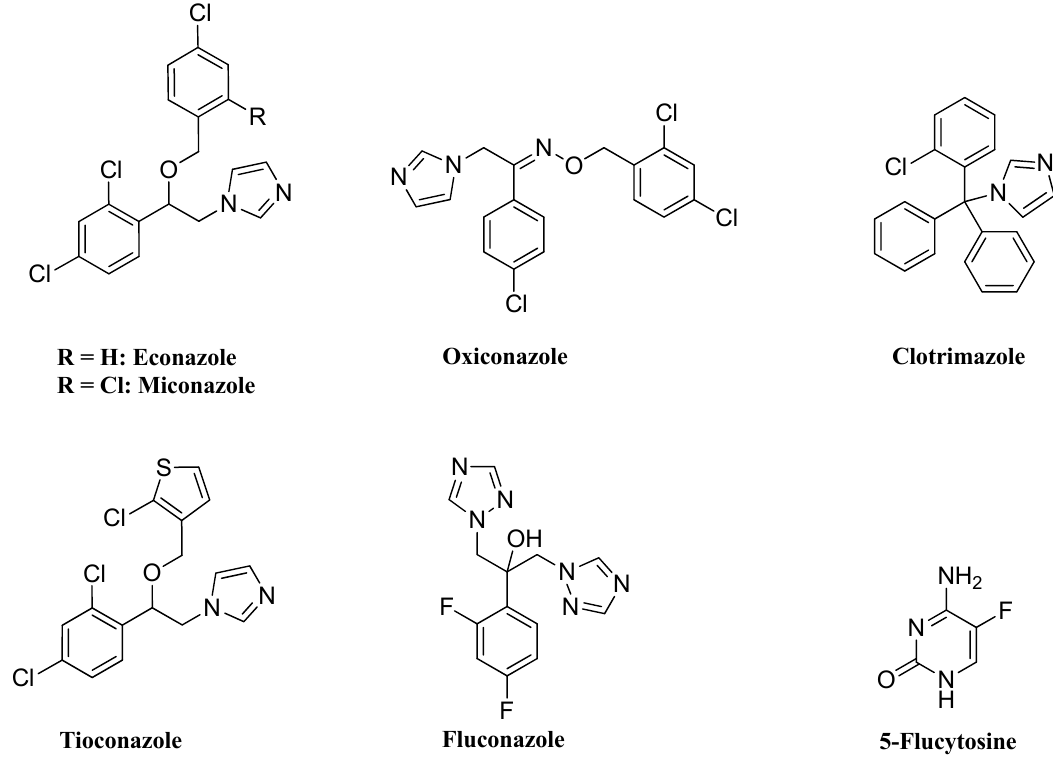
Figure 1. Azole antifungal agents used in clinical